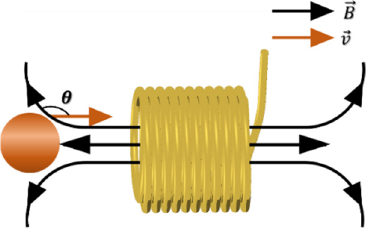
Figure 6. Schematic diagram of cutting magnetic field lines in the direction of movement of metal